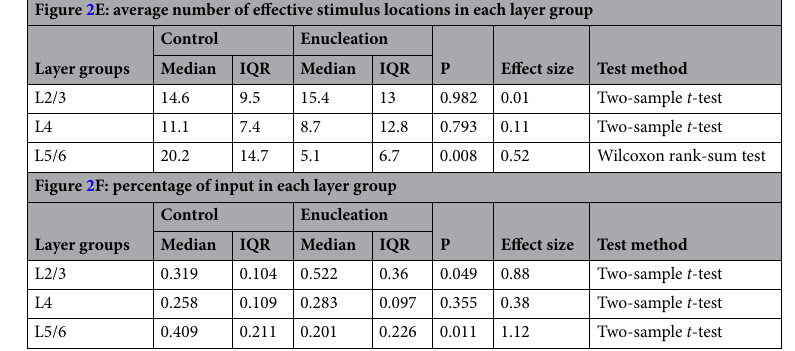
Figure 2E: average number of effective stimulus locations in each layer group